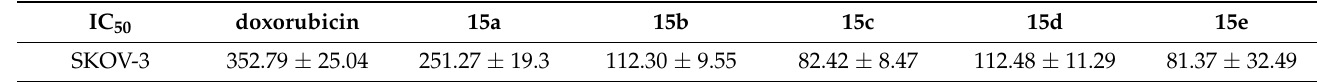
Figure 11. Chemical structures of formamidino-doxorubicin derivatives synthesized via the amino group ( 15a – e ). Table 3. IC 50 values of compounds 15a-e against SKOV-3 cancer cell